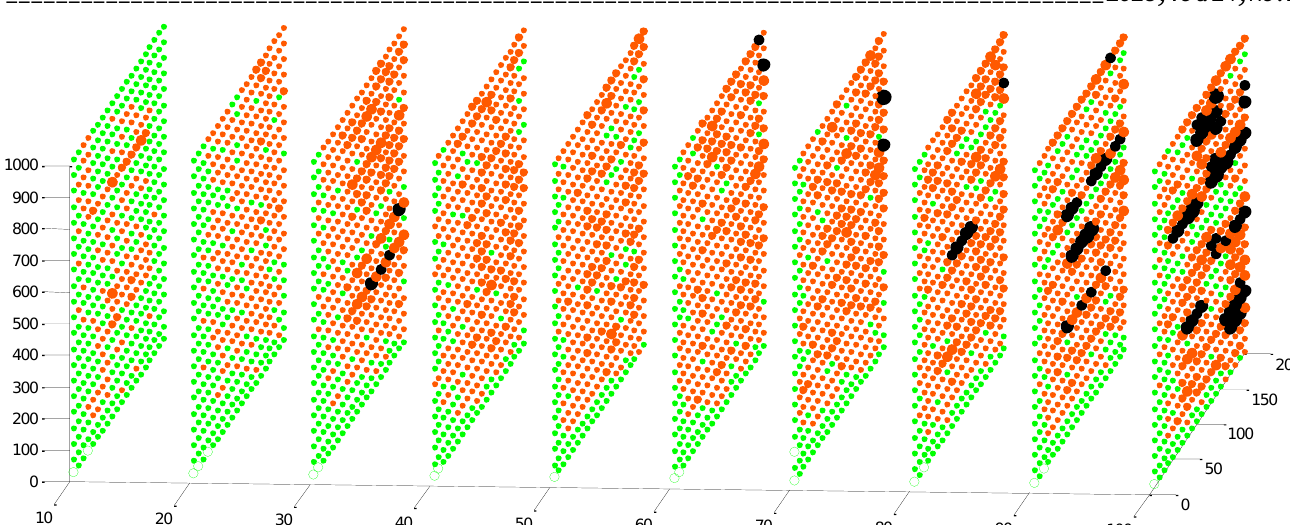
c on CIFAR-10 images. The circled dots stand for the (unacceptable) accuracies less than 60 %. Overall accuracy is poorer by Fig. 4. Performance 28